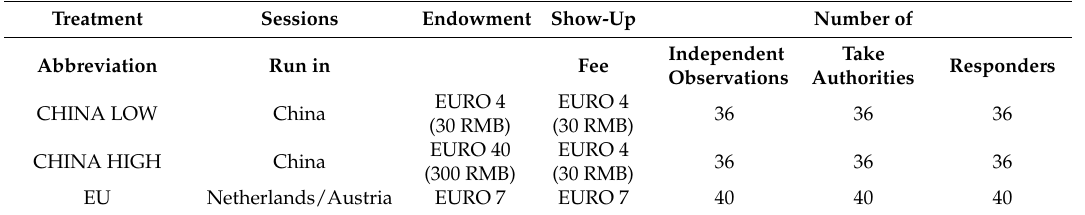
Table 1. Experimental